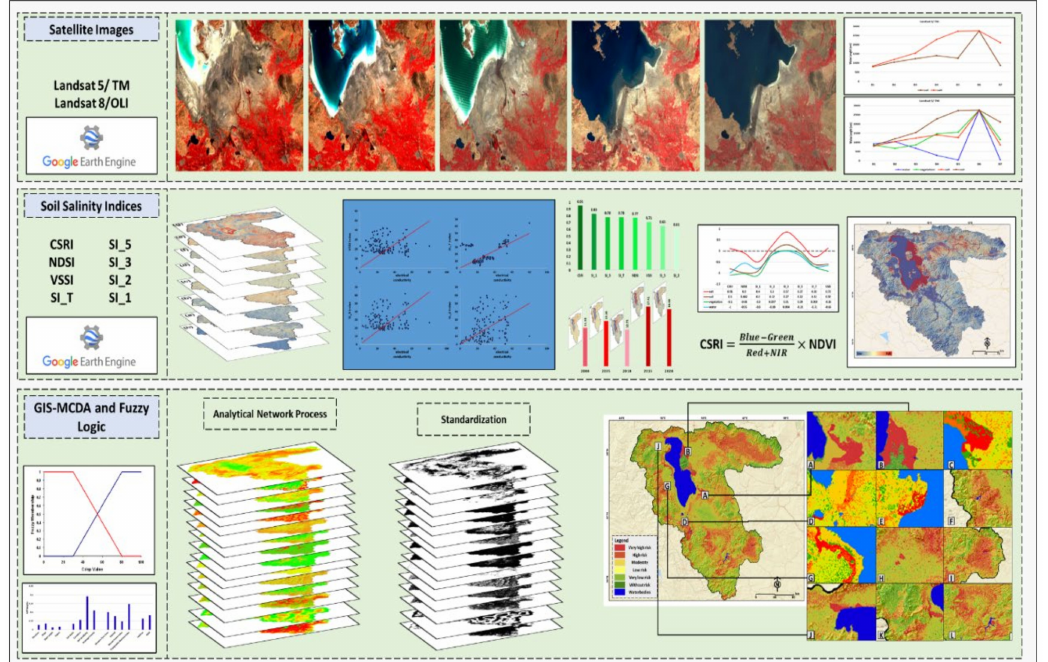
Figure 2. Flowchart for the main schema of the research methodology. The upper and middle parts of this figure show the implementation of the time-series satellite image analysis for soil salinity monitoring and validation. The lower section shows the research methodology for a MCDA approach for soil degradation